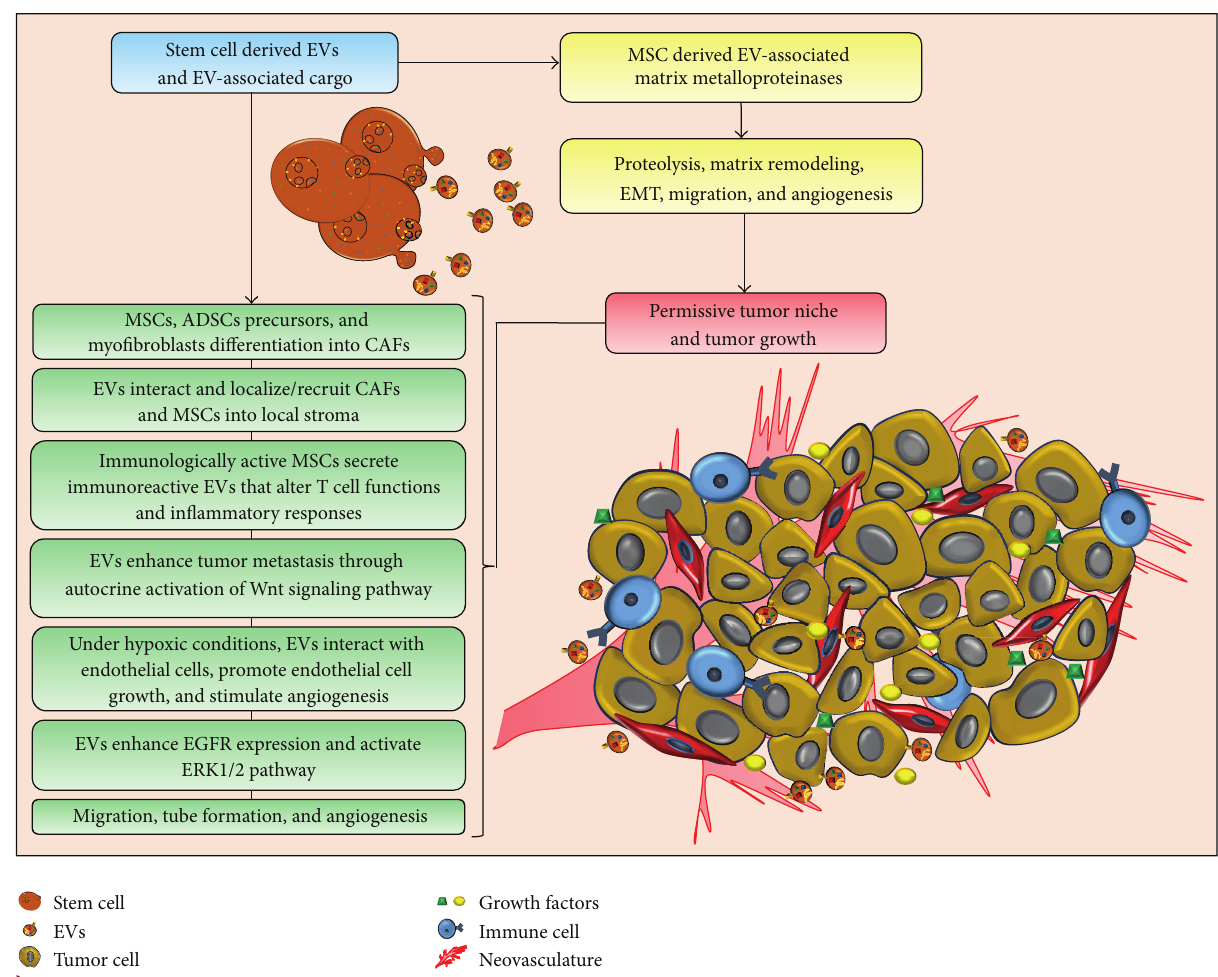
Figure 2: Contribution of stem cell-derived EVs in the construction of the tumor microenvironment. Stem cell-derived EVs influence the presence of cancer-associated fibroblasts (CAFs), inflammatory immune cells, metalloproteinases, angiogenic growth factors, and regulatory RNAs, which shape the tumor microenvironment. Extracellular matrix (ECM) remodeling, endothelial cell growth, cell migration, and angiogenesis generate a permissive tumor